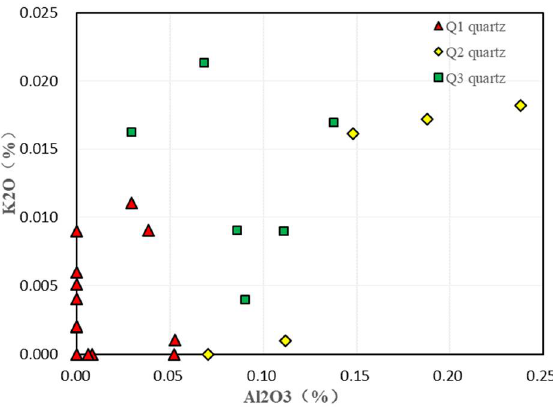
Figure 7. Relationship between Al 2 O 3 and K 2 O in the different quartz cement phases.